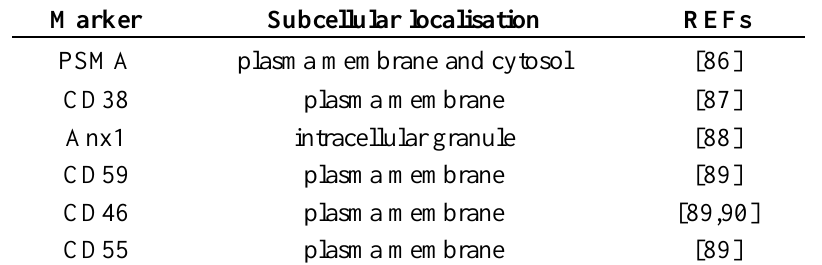
Table 2. Prostasomes protein markers and their common subcellular